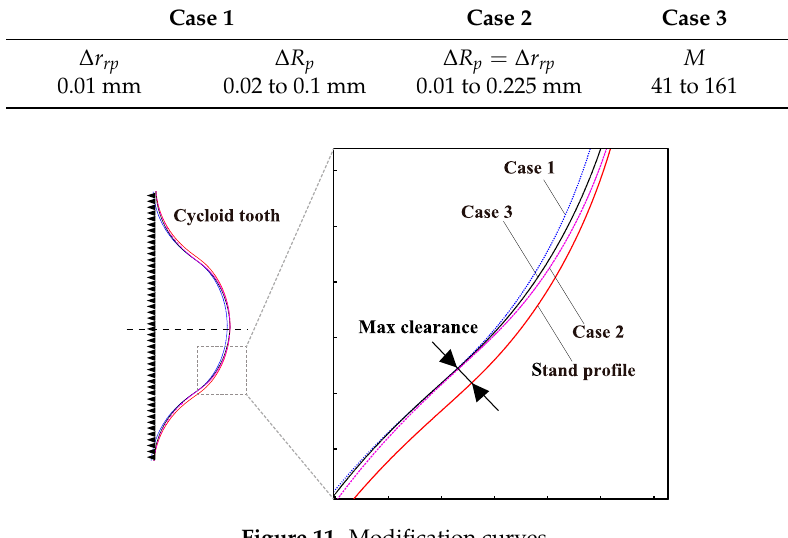
Figure 11. Modification curves. Table 6. Modification conditions.